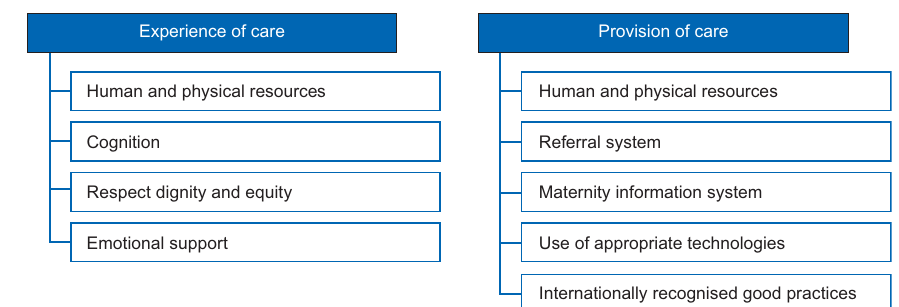
Figure 1: Conceptual framework for the quality of care in maternity services 12